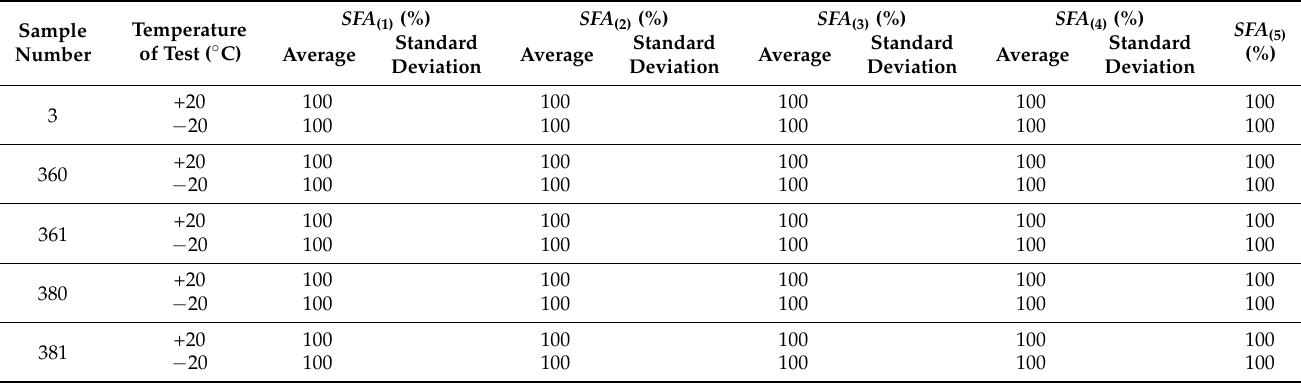
Table 7. Values of the SFA ( n ) (%) parameters determined for X6CrNiTi18-10 steel, determined on impact toughness test fractures obtained during this research.